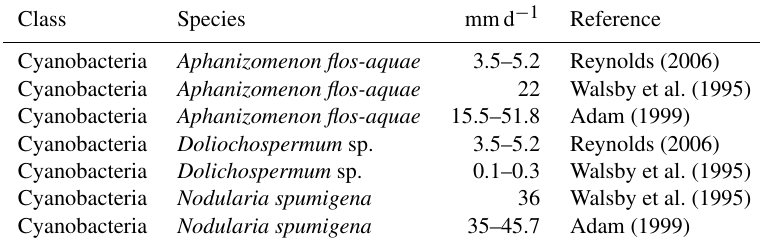
Table 10. Sinking/floating speeds of different